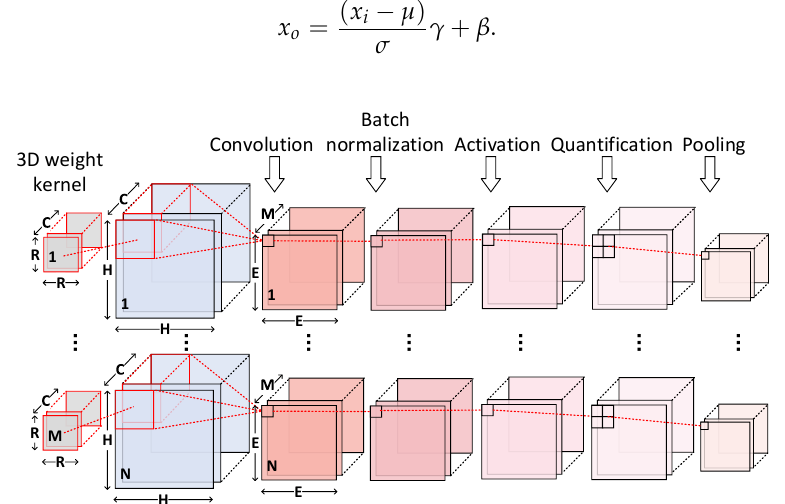
Figure 2. Basic stage of a CONV-based layer